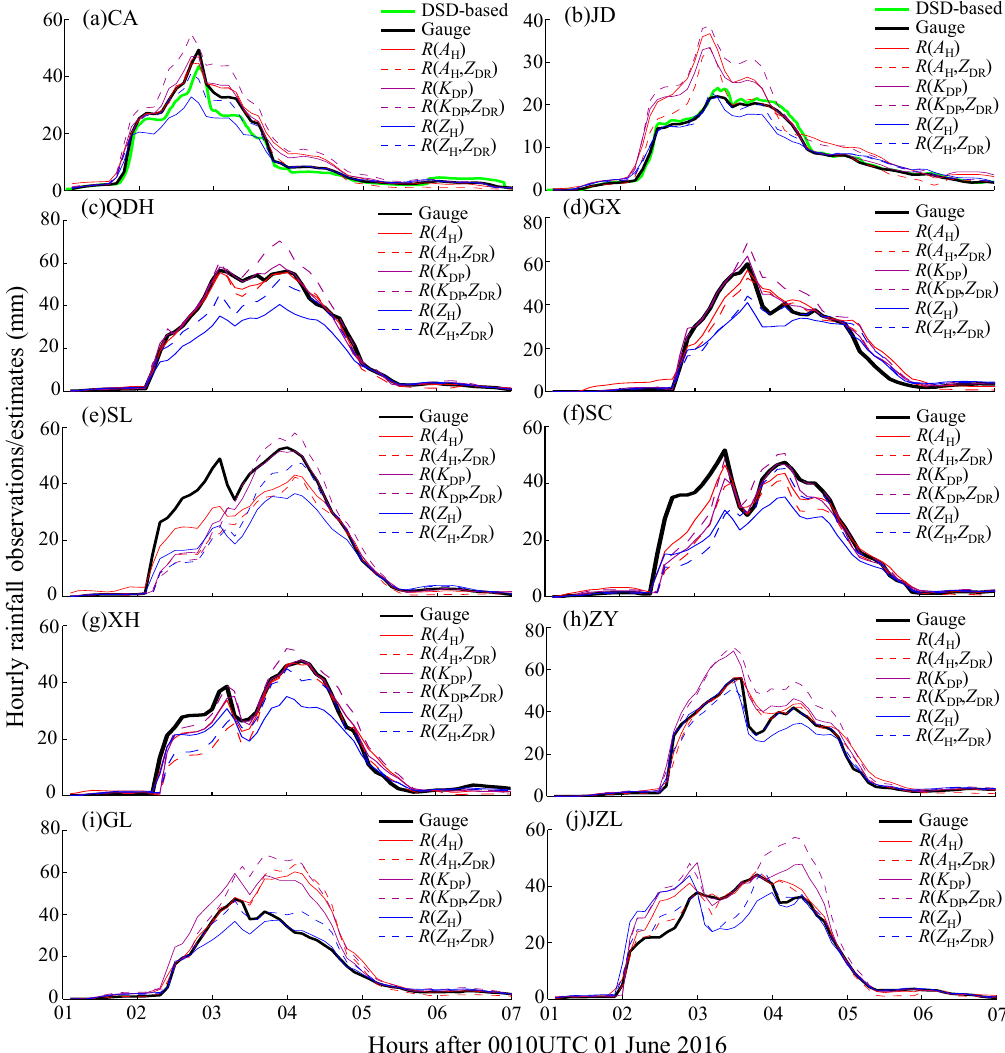
Figure 10. Time series of hourly rainfall estimates for 60 minute moving windows from the 10 gauges, disdrometer and radar between 0100–0700 UTC on 1 June 2016: ( a ) CA, ( b ) JD, ( c ) QDH, ( d ) GX, ( e ) SL, ( f ) SC, ( g ) XH, ( h ) ZY, ( e ) GL and ( j ) JZL.